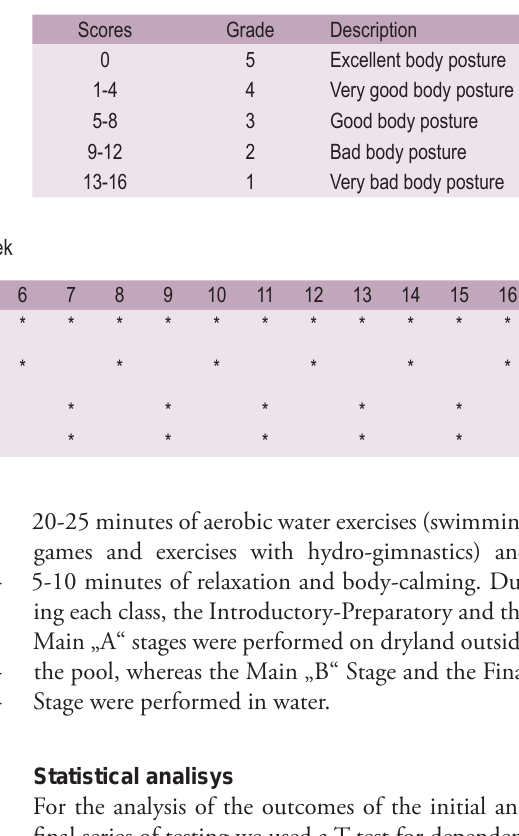
TABLE 3. De fi ning the posture status according to Wolanski